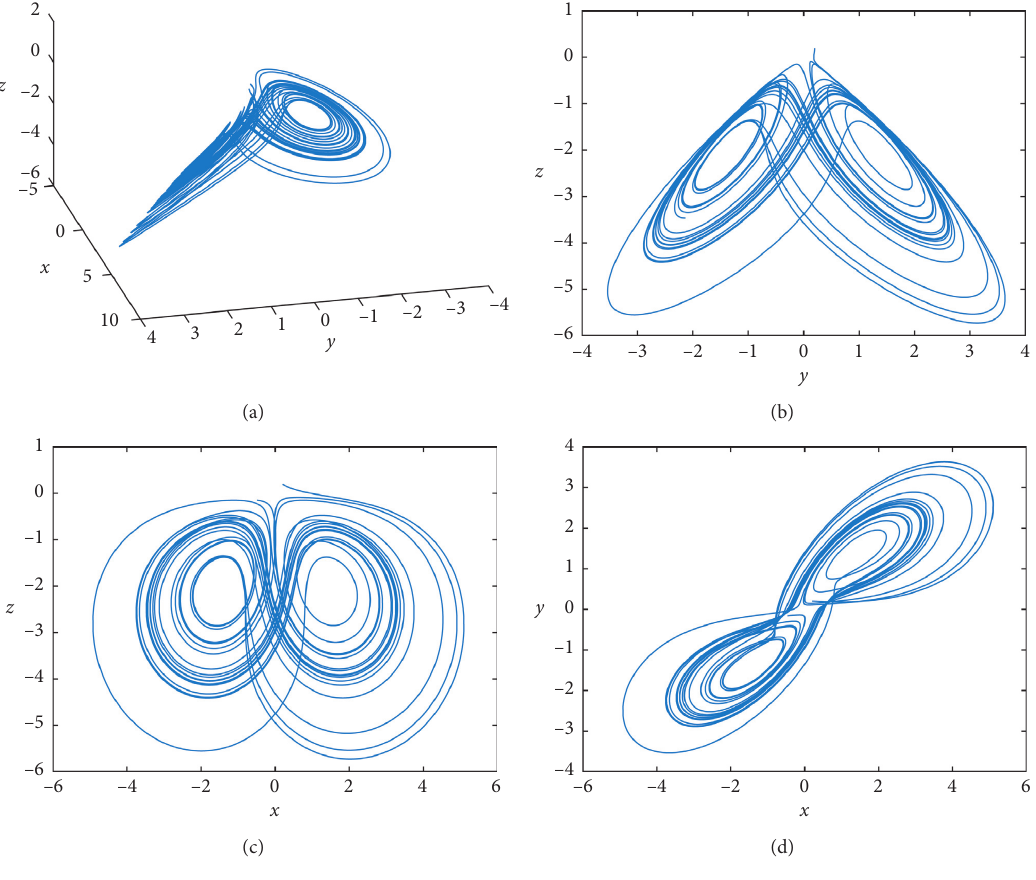
Figure 1: Phase portraits with the order α � 0 . 95.